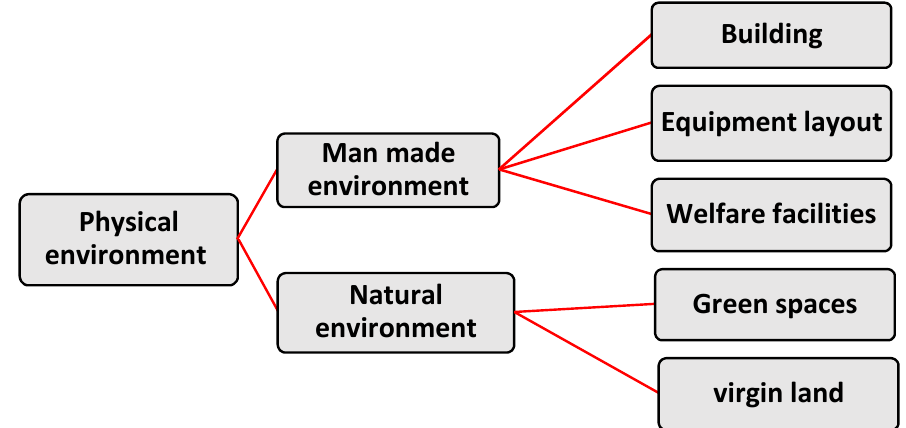
Fig. 1. The classification of the physical environment of a hospital